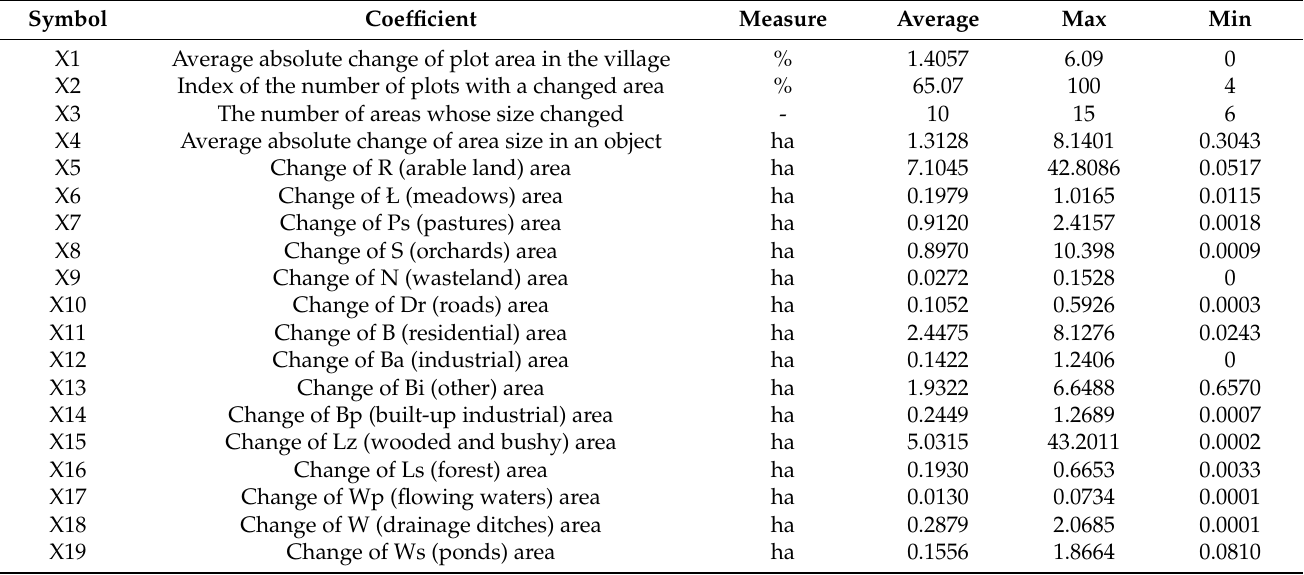
Table 1. Basic parameters of raw